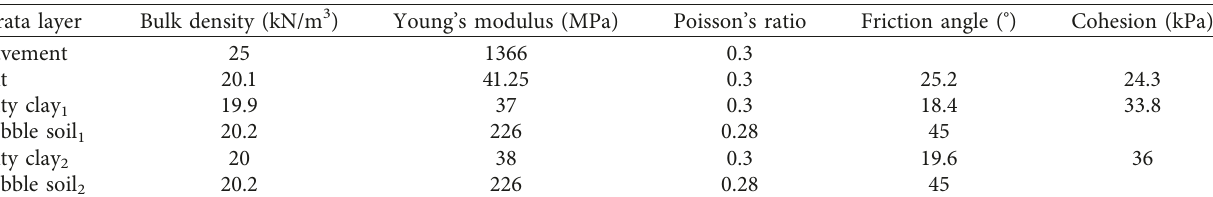
Figure 15: Three-dimensional model of slurry shield TBM tunnelling: (a) 3D overview for DK17 +885; (b) 3D overview for DK17 +400; (c) discretization of the model. Table 1: Physical and mechanical properties of the